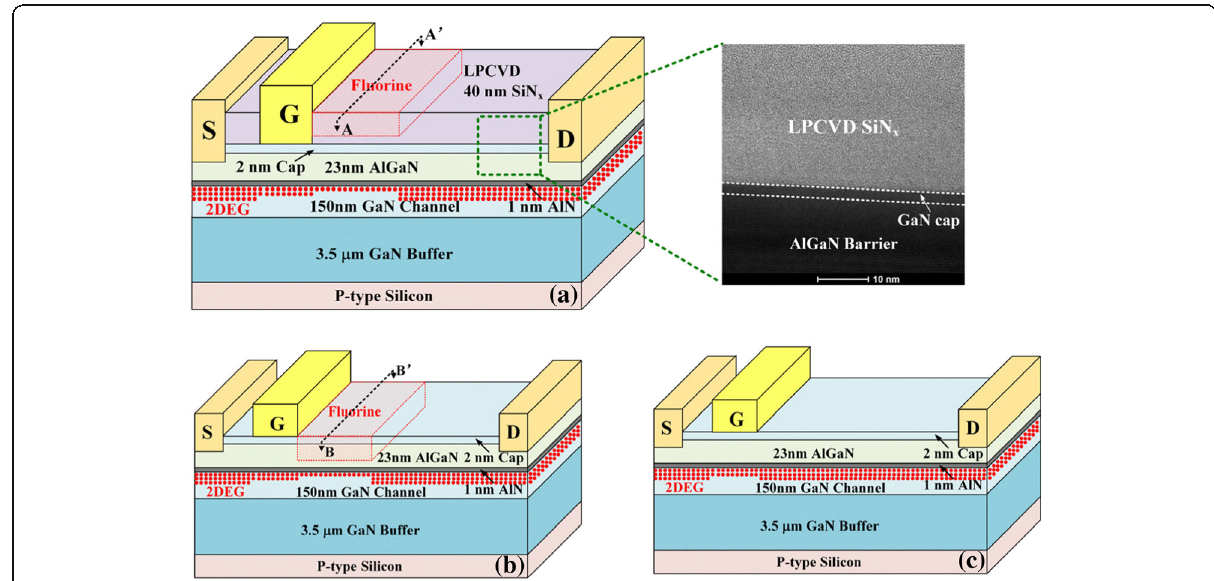
Fig. 1 Three-dimensional schematic of a FPL HEMT (inset: HR-TEM micrograph of LPCVD SiN x ), b FBL HEMT, and c Conv.